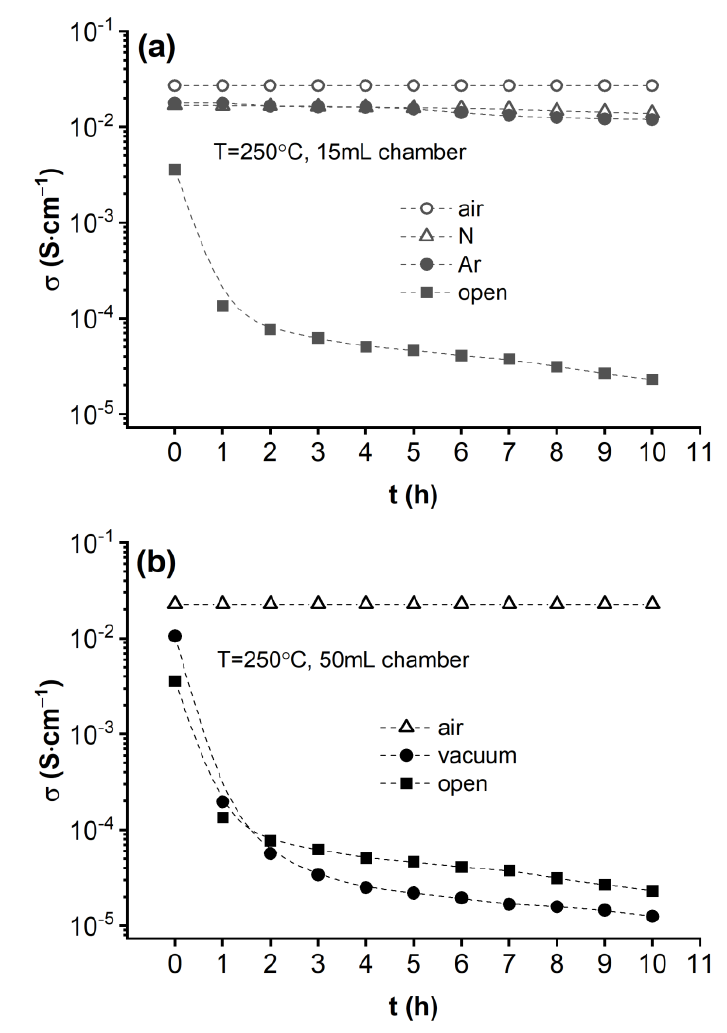
Figure 4. ( a ) Time dependence of the proton conductivity of CDP hermetically sealed in the 15 mL chamber at T = 250 ◦ C in dry air (circles), nitrogen (triangles), argon (filled circles), and in an open atmosphere (filled squares). ( b ) Time dependence of the proton conductivity of CDP hermetically sealed in the 50 mL chamber at T = 250 ◦ C in dry air (triangles) and vacuum (filled circles), as well as outside of the chamber in open air (filled squares).